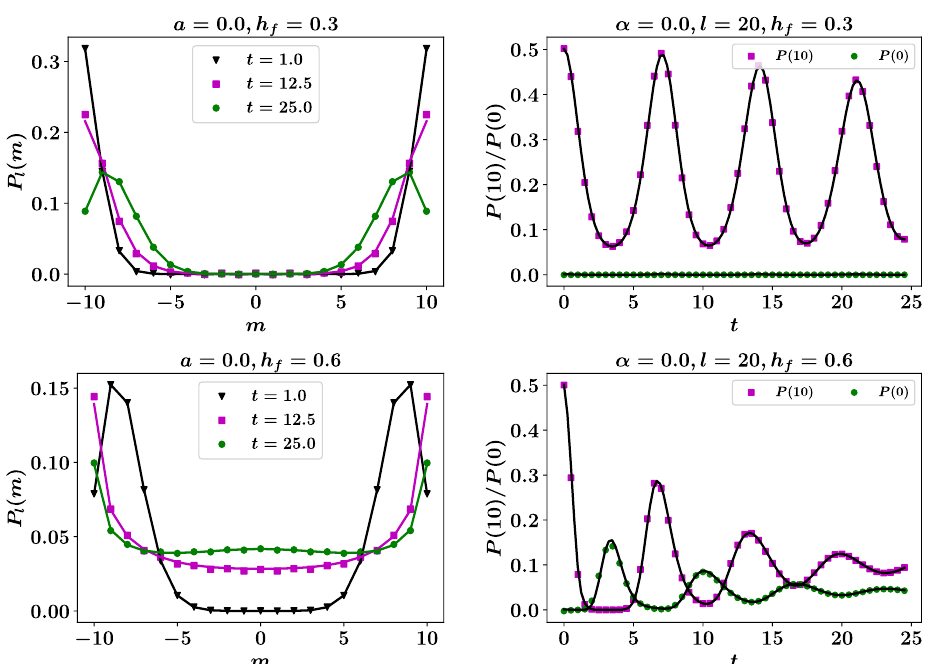
Figure 9: PDF of subsystem magnetization of fully connected Ising model after quan- tum quench. The first panels on the left column are PDF at three representative time slices at two values of final transverse field. The panels on the right are the time evolution of formation probabilities, P transverse fields. The full lines are exact results calculated from equation 26 whereas the symbols are TDVP